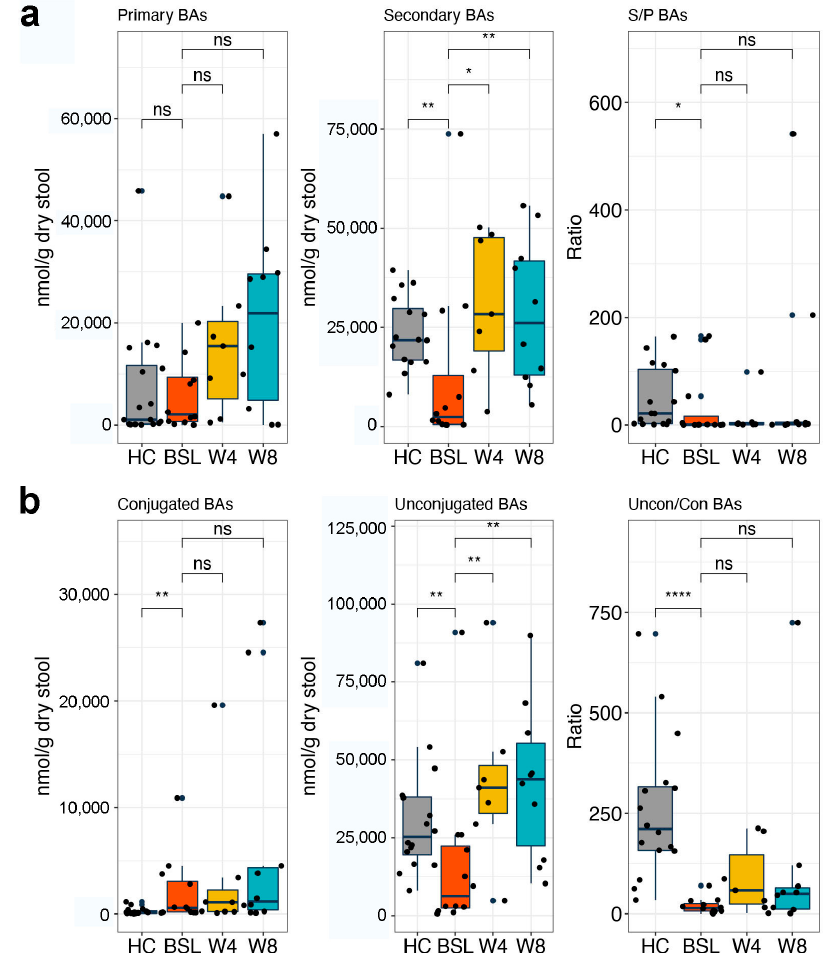
Figure 4. Analysis of fecal bile acid concentrations in pediatric CD patients during EEN induction therapy. ( a ) Primary and secondary BA levels, and ratio of secondary to primary BAs. ( b ) Conjugated and unconjugated BA levels, and ratio of unconjugated to conjugated BAs. Significance was deter- mined via Mann–Whitney U test. * p < 0.05; ** p < 0.01; **** p < 0.0001. BAs, bile acids; HC, healthy controls; BSL,